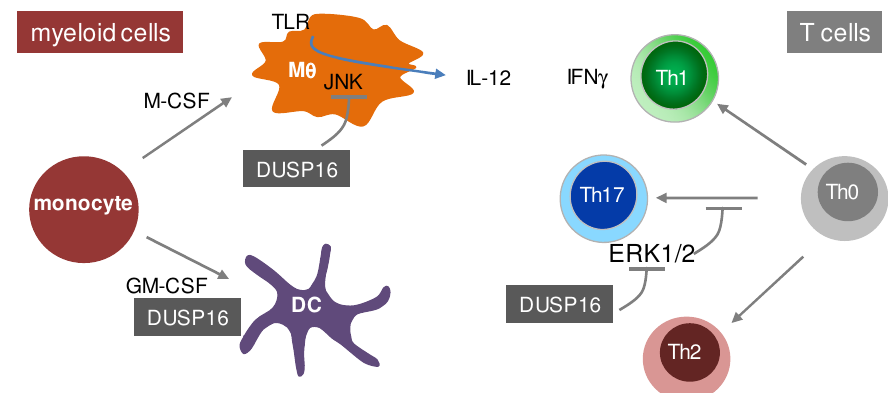
Figure 4. Role of DUSP16 in innate and adaptive immune cells . Analysis of CD4 + T cell compartment and myeloid cells derived from radiation chimeras with a DUSP16-deficient hematopoietic system was performed by two labs [104,107].